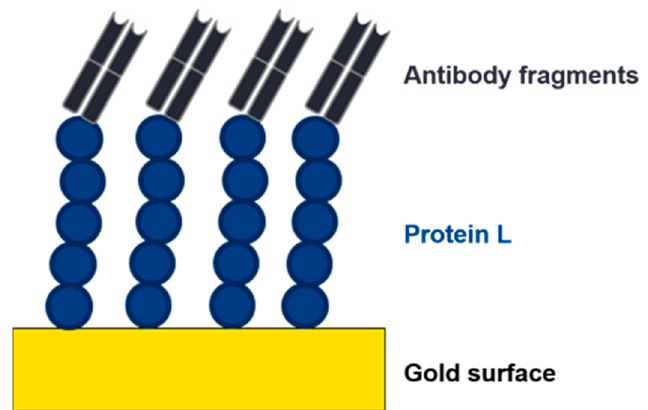
Figure 8. Depiction of an electrochemical impedance spectroscopy (EIS) sensor. An affinity ligand (e.g., protein L) is immobilized to a gold surface. Due to the interaction with an analyte, the charge transfer resistance changes, and the analyte can be detected and quantified.